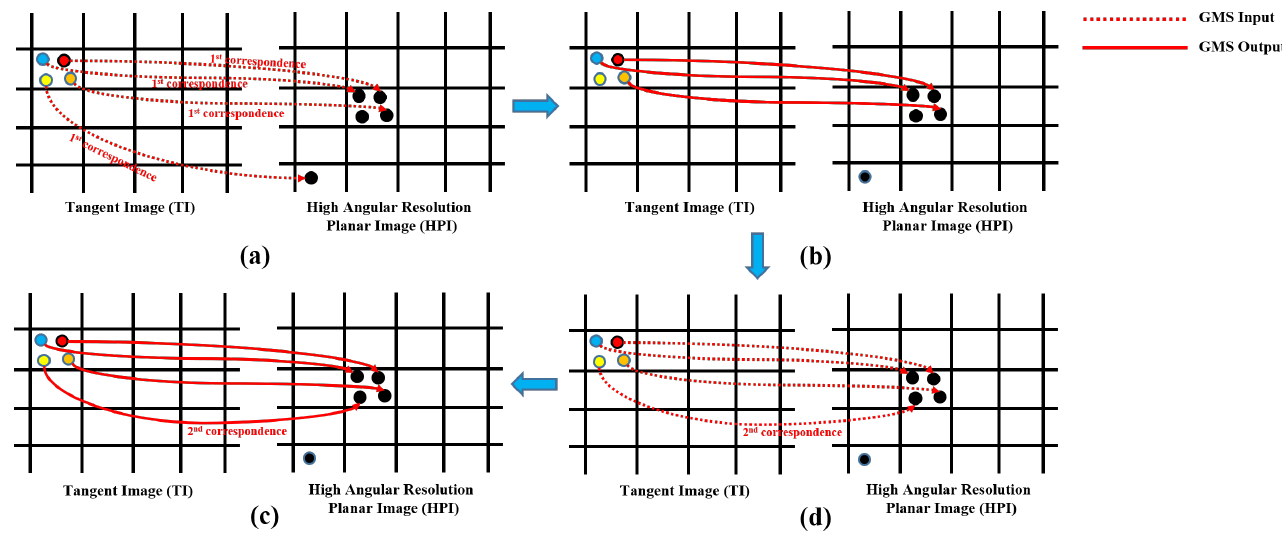
Figure 10. Failure case of the Proposed kNN-based GMS feature matcher. ( a ) We use the 1st correspondence to perform the first iteration of the GMS matcher. Note that the similar neighbors (i.e., blue, red, and orange points) correspond to the wrong correspondences. ( b ) shows the result of the first iteration. The yellow feature has 1st correspondence far from the neighbor correspondences; GMS did not identify it as the similar neighbors as the others (i.e., no red line for the yellow feature). ( c ) showed the preparation for the second iteration of GMS matcher with the yellow feature is now switched to its 2nd correspondence. ( d ) As the 2nd correspondence is close to the neighbor correspondences, GMS would identify it as similar neighbors (i.e., the red line for the yellow feature. However, as the matches in the neighbors are wrong, the yellow feature is also a wrong